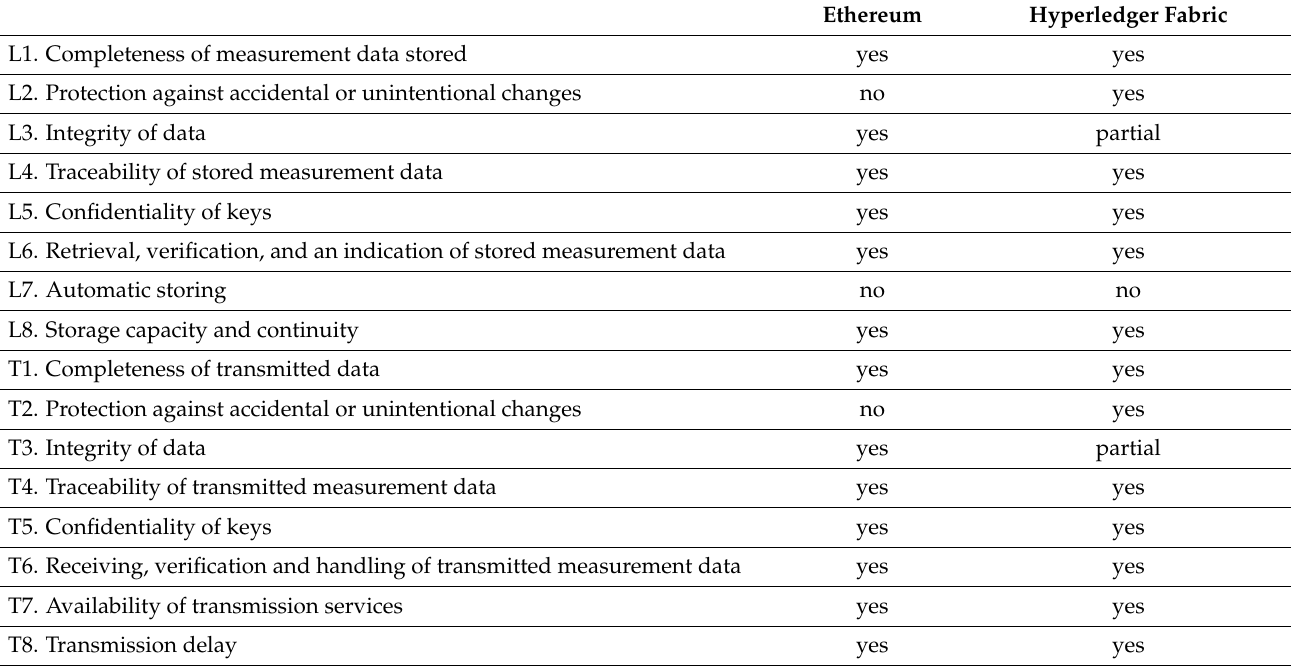
Table A2. Blockchain platforms and WELMEC